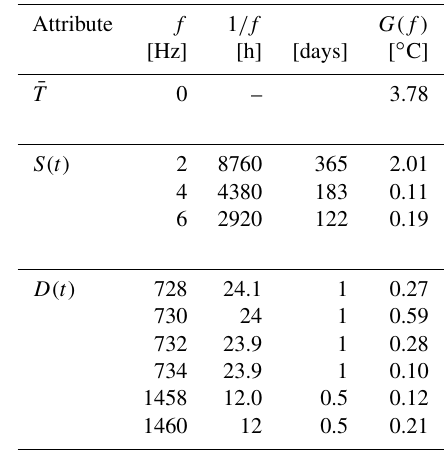
Table 1. Frequency f , period 1 /f , and spectral intensity G(f ) of trigonometric curves (threshold of G(f ) >0.1) composing the fol- lowing thermal attributes: average ¯ T , seasonal periodicity pattern S(t) , and diel periodicity pattern D(t)